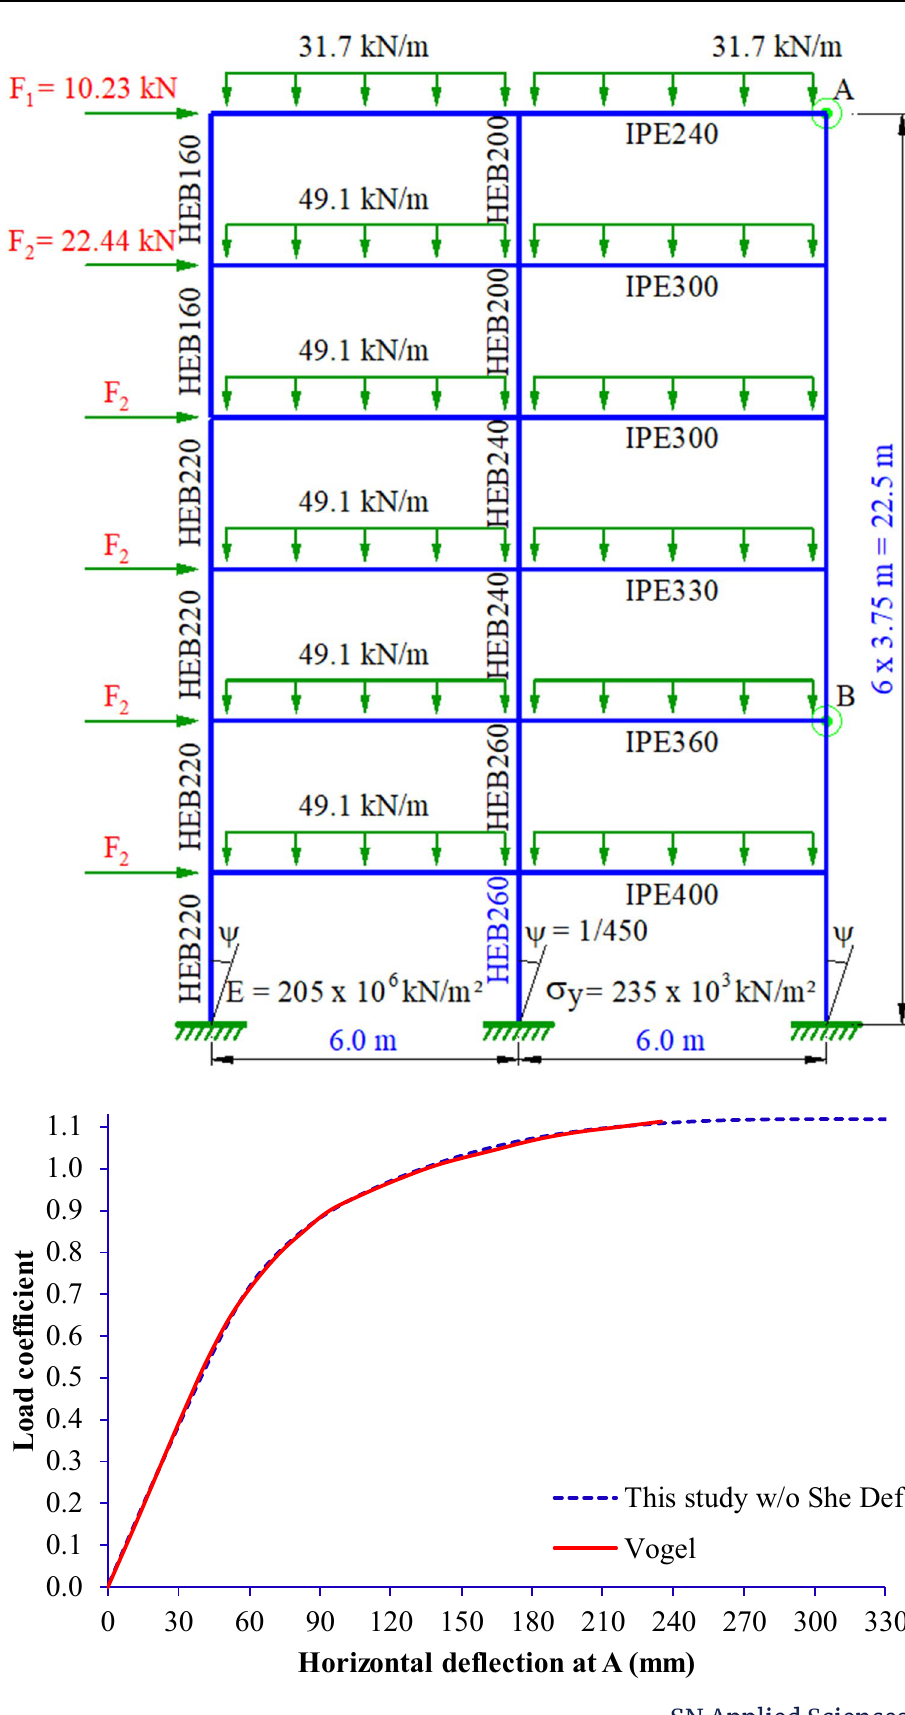
Fig. 11 Load-horizontal deflection relationship at A of six-story